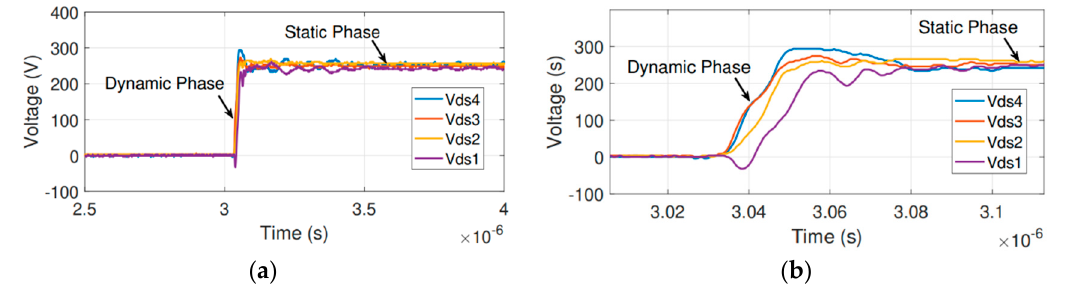
Figure 15. Voltage balancing achieved by the calibration process without FR4 package ( a ) and its zoomed view ( b ); CASE 1.